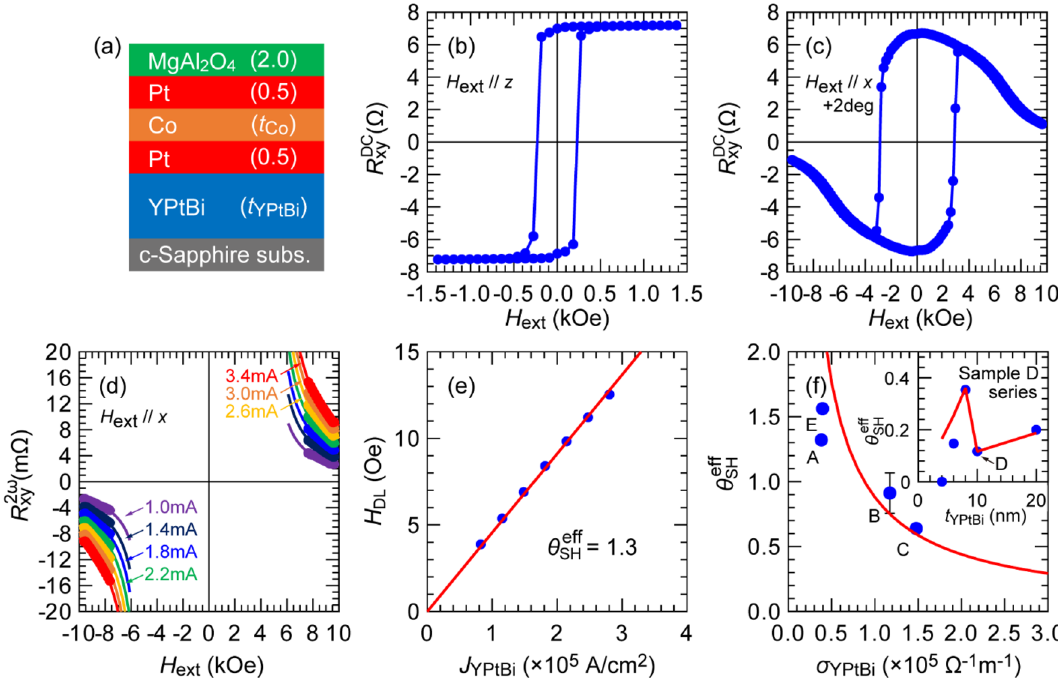
Figure 4. ( a ) Schematic illustration of sample structure for spin Hall effect measurements, where layer thicknesses are in nm. ( b , c ) DC anomalous Hall resistance for sample A ( σ YPtBi = 0.38 × 10 5 Ω −1 m −1 and t Co = 0.5 nm) measured with H ext applied along the z -direction and the x + 2°-direction, respectively. ( d ) Second harmonic Hall resistance of sample A measured with H ext applied along the x -direction and an AC current ranging from 1.0 to 3.4 mA, where dots are experimental data and solid curves show fitting results given by Eq. (2). ( e ) Antidamping-like field H DL as a function of the current density in the YPtBi layer. ( f ) Relationship between the effective spin Hall angle and the conductivity of the YPtBi layer observed in sample A, sample B ( σ YPtBi = 1.2 × 10 5 Ω −1 m −1 and t Co = 0.5 nm), sample C ( σ YPtBi = 1.5 × 10 5 Ω −1 m −1 and t Co = 0.8 nm), and sample E ( σ YPtBi = 0.39 × 10 5 Ω −1 m −1 and t Co = 0.5 nm). Inset shows the thickness dependence of the effective spin Hall angle in another series of samples. Sample D ( σ YPtBi = 2.0 × 10 5 Ω −1 m −1 and t Co = 0.5 nm) is a representative sample in this